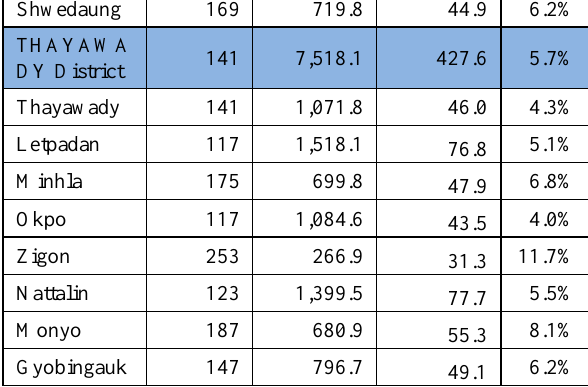
Table 1: Population density by political boundary, settlement area and settlement ratio of Bago